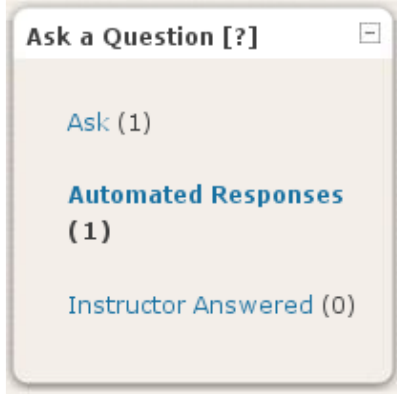
Figure 3. Moodle student plugin to QA